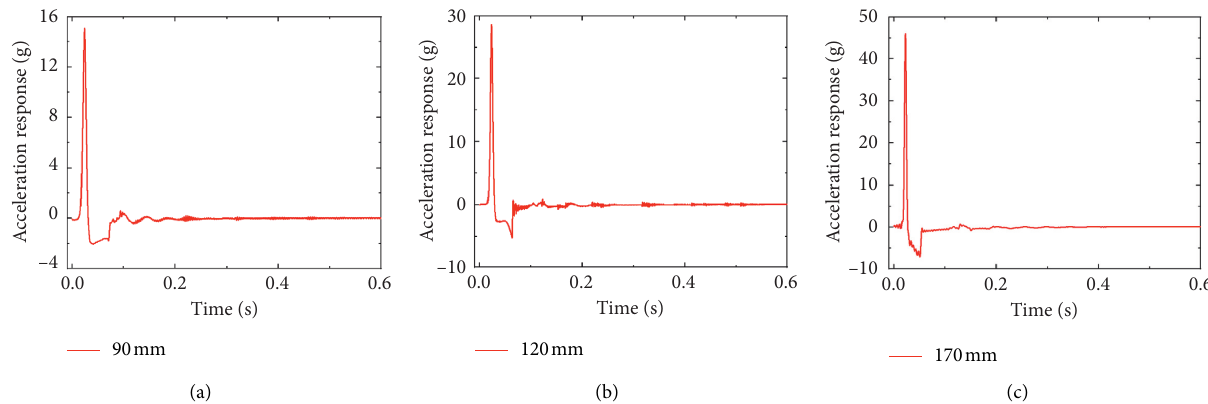
Figure 16: The signal input from different drop heights. (a) The drop height is 90 mm. (b) The drop height is 120mm. (c) The drop height is